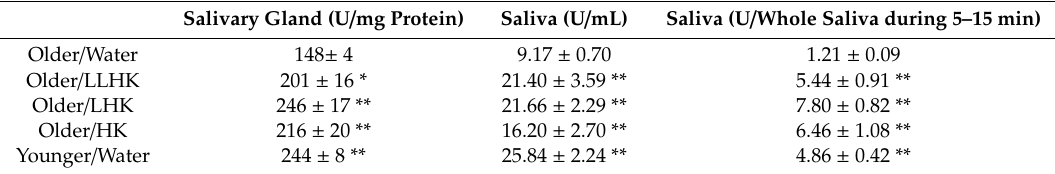
Table 5. Amylase activity in parotid gland and